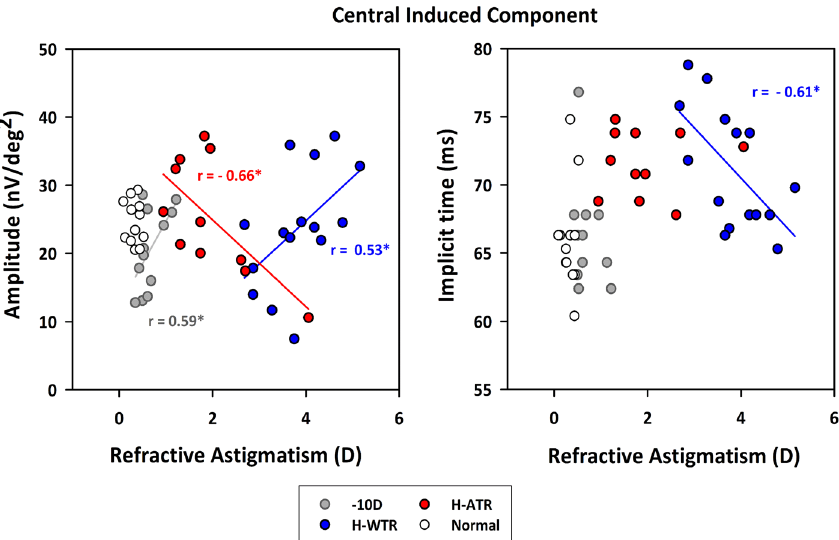
Figure 3. Correlations between refractive astigmatism with amplitude (Left) and implicit time (Right) of the central induced component (IC). Refractive astigmatism is plotted against the amplitude (left) and implicit time (right) of the central IC responses in normal and treated eyes with spherical (− 10 D) or the two sphero- cylindrical lenses (H-WTR and H-ATR). Different colored symbols/lines represent different groups as shown in the legends. Only Pearson’s r with statistical significance is shown. The levels of significance are represented by asterisk: p <